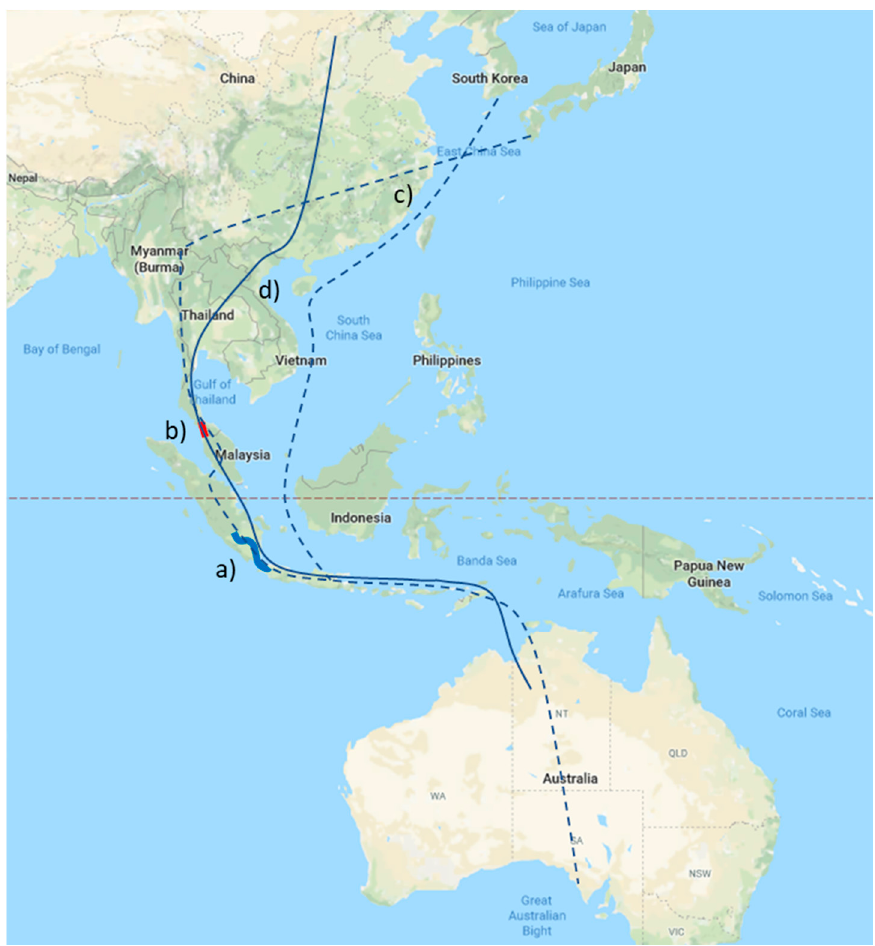
Figure 3. Two proposed routes for the Pan-Asian Energy Infrastructure scenario—Under consideration/development: transmission path of the ISJ, Section 3.2.2 ( a ), existing: Thailand (Khlong Ngae)—Malaysia (Gurun), Section 3.3.6 ( b ) and proposed ( c , d ) transmission links that could form an Asian electricity grid.